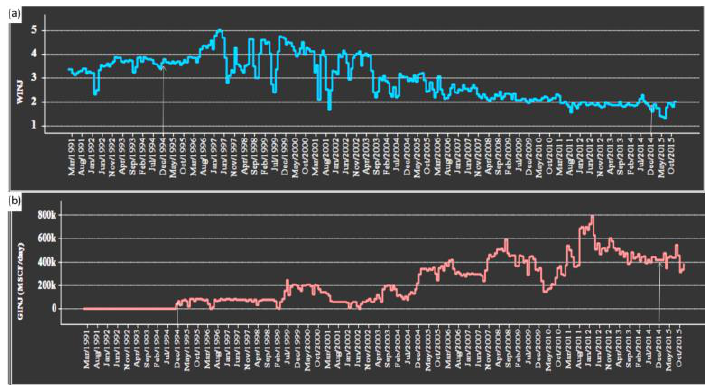
Figure 11. Reservoir performance over time. ( a ) Oil, gas, and water saturation in Mscf/day and ( b ) water cut %.